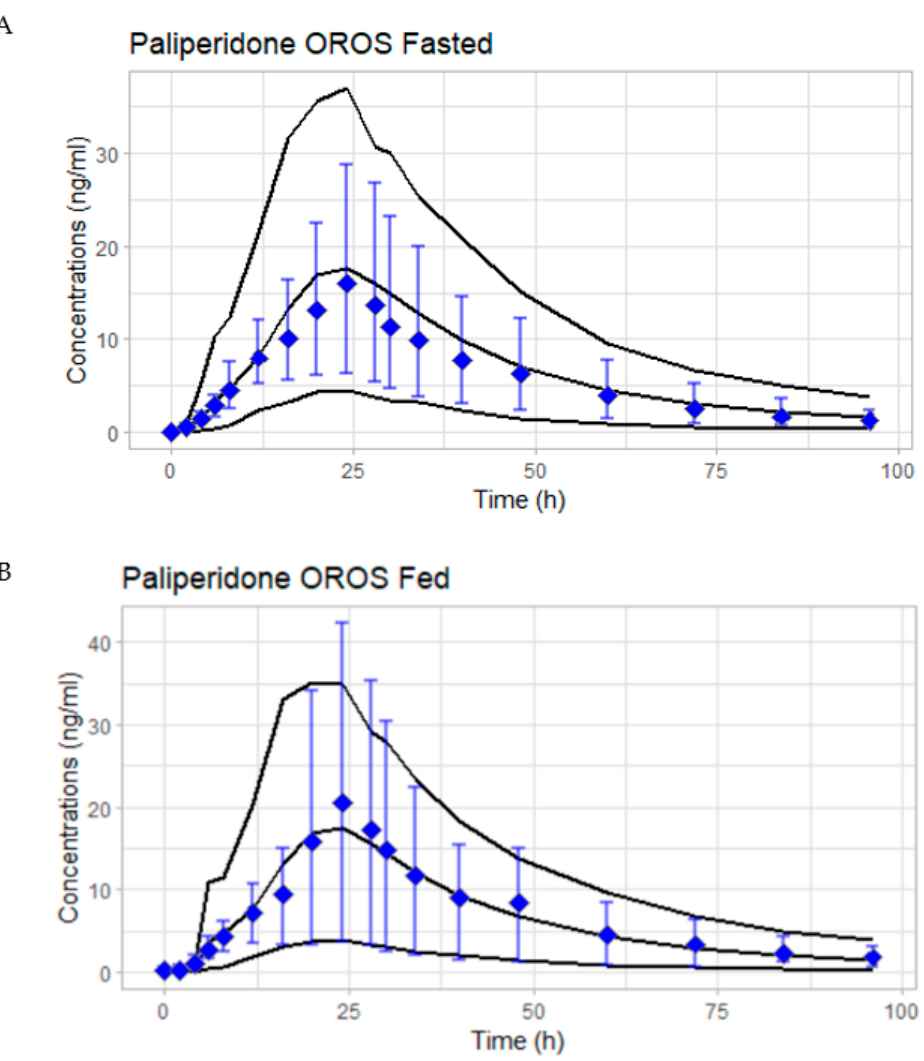
Figure 7. Population simulations of 10 different trials of N = 25 subjects each in fasted state ( A ) and fed state ( B ); plots are showing the simulated overall mean plasma concentrations of the 10 trials together and the 95% prediction bounds (black lines). The observed mean plasma concentration ± 95% bounds of the observations are presented using blue dots and bars.